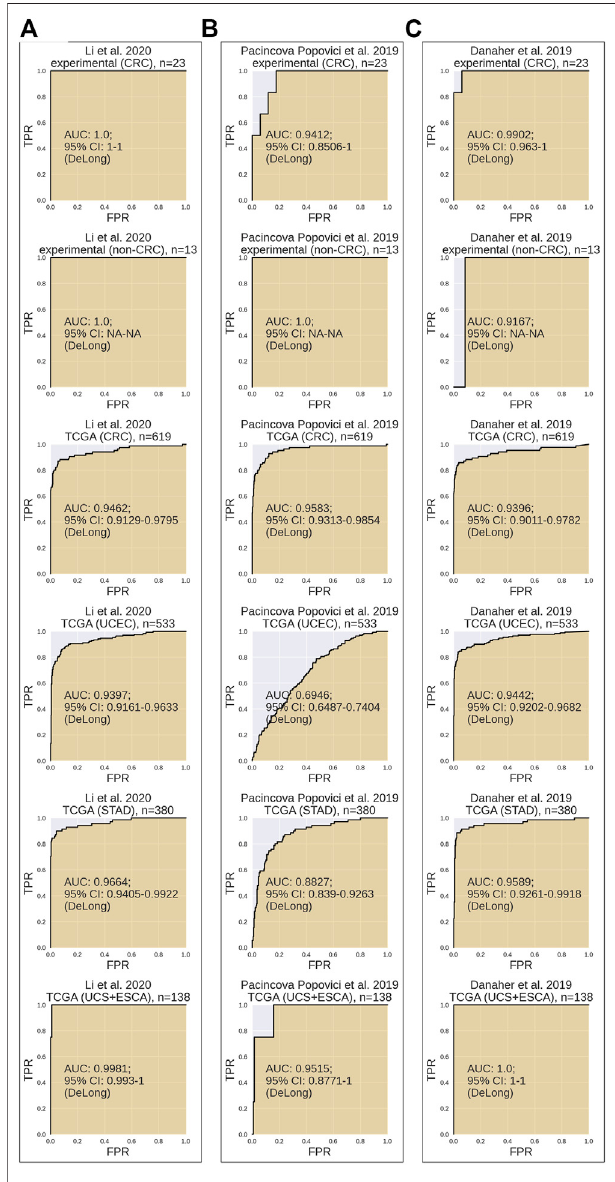
FIGURE 2 | Performance test of MSI RNAseq gene signatures. All signatures were tested for assessment of MSI status on CRC experimental dataset, non-CRC experimental dataset, TCGA CRC dataset, TCGA UCEC dataset, TCGA STAD dataset, and joint TCGA UCS + ESCA